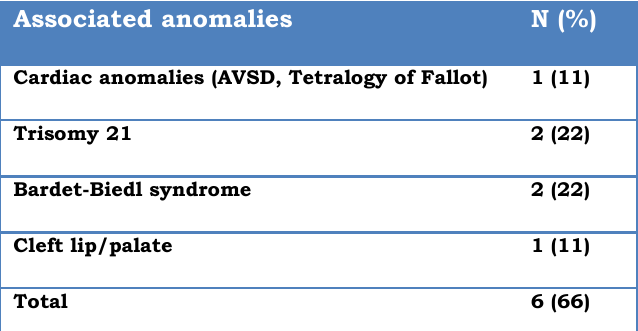
Table 1: Associated anomalies in cases of total